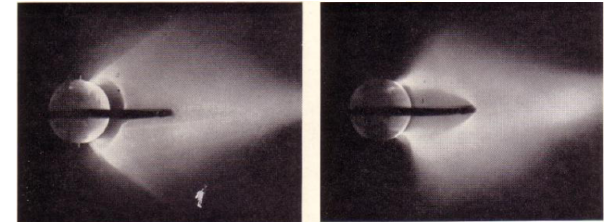
Figure 4. Ernst Br¨uche’s version of Birkeland’s terrella simula- tions with electric currents added. The current in the equator plane is turned o ff/ on in the left / right picture. They illustrate that the ring current moves the auroral zones toward the magnetic equator (Br¨uche, 1930).